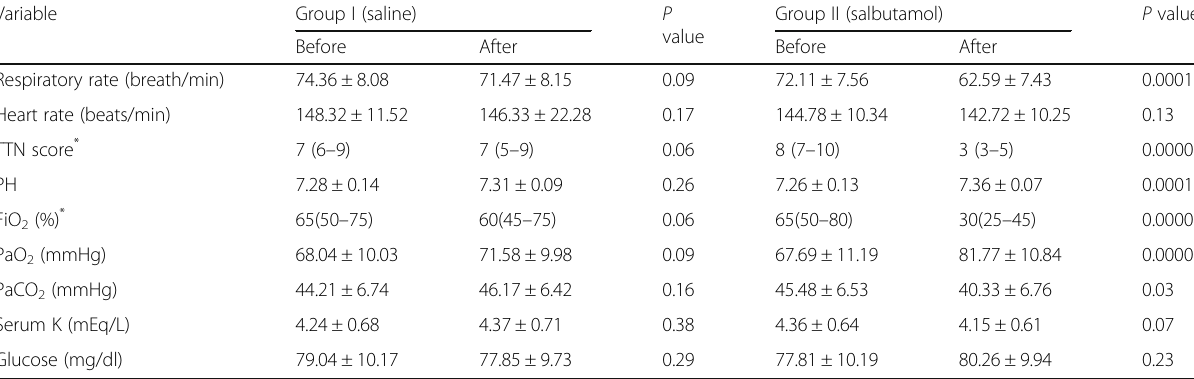
Table 3 Comparison of data before and 4 h after treatment among study groups Variable